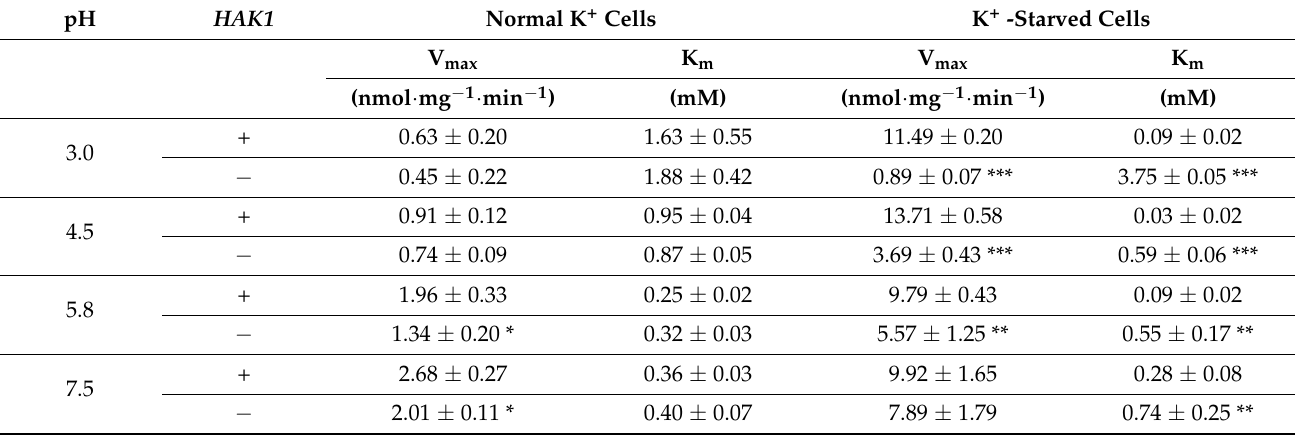
Table 1. Apparent kinetic parameters for rubidium transport in normal K + cells and K + -starved cells of Candida albicans strains. pH